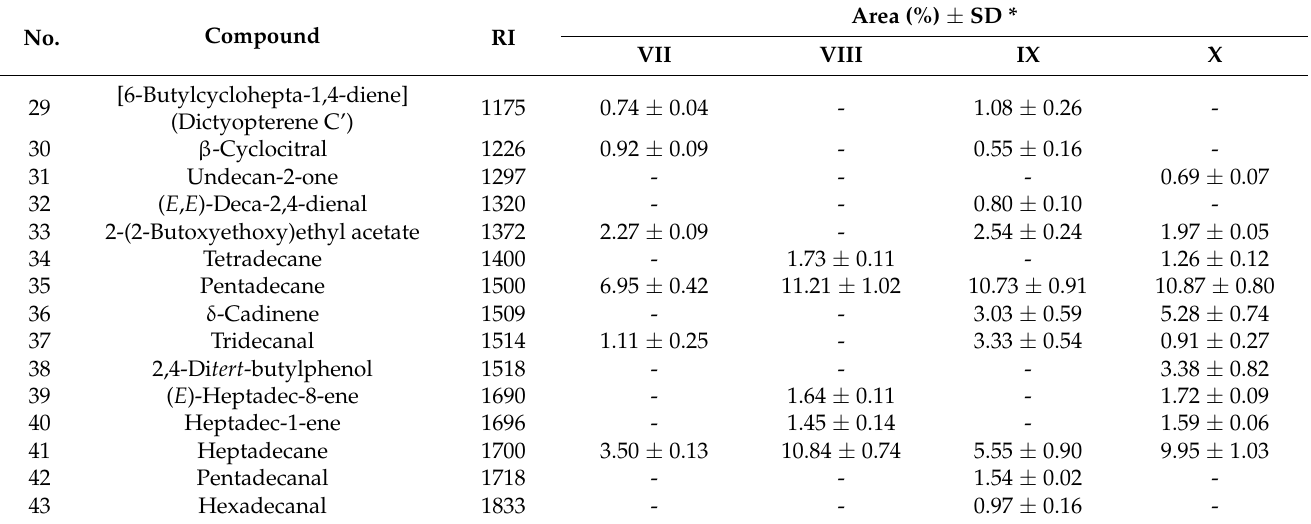
sample (HD-DrEA) (Figure 7).